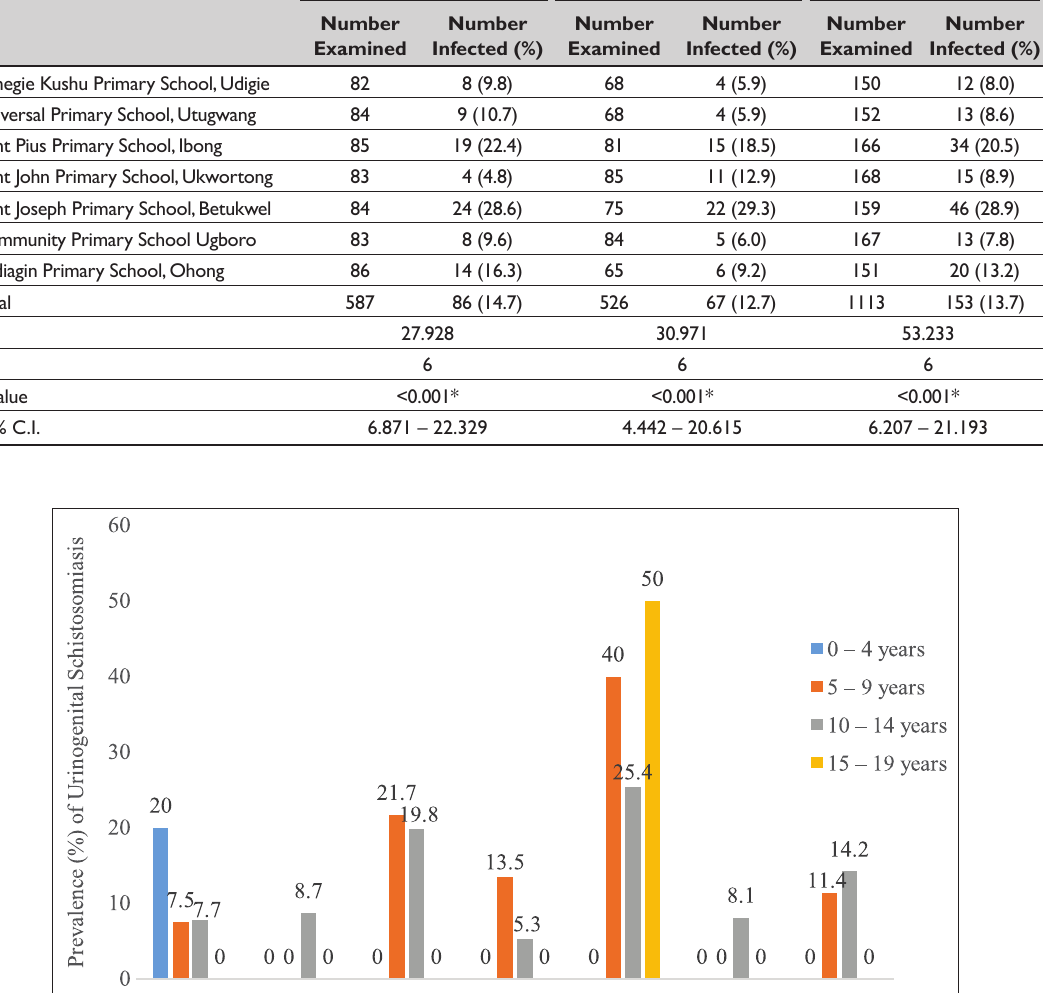
Table 2: Prevalence of urogenital schistosomiasis by sex in each school in the study area Schools